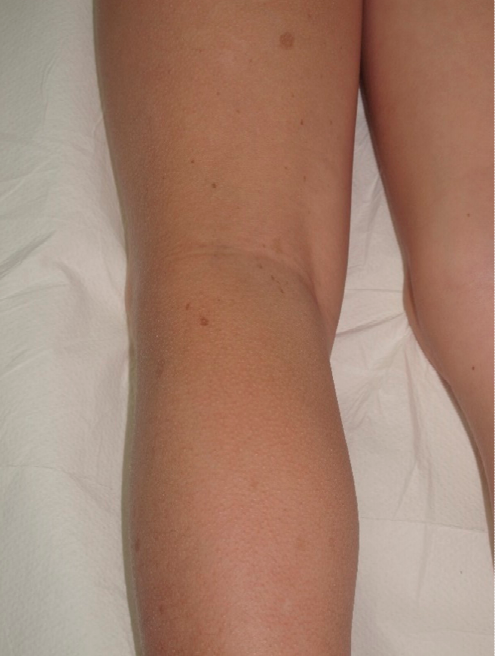
Figure 5. Small CALMs of the left thigh of a young child associated with early flexural freckling.